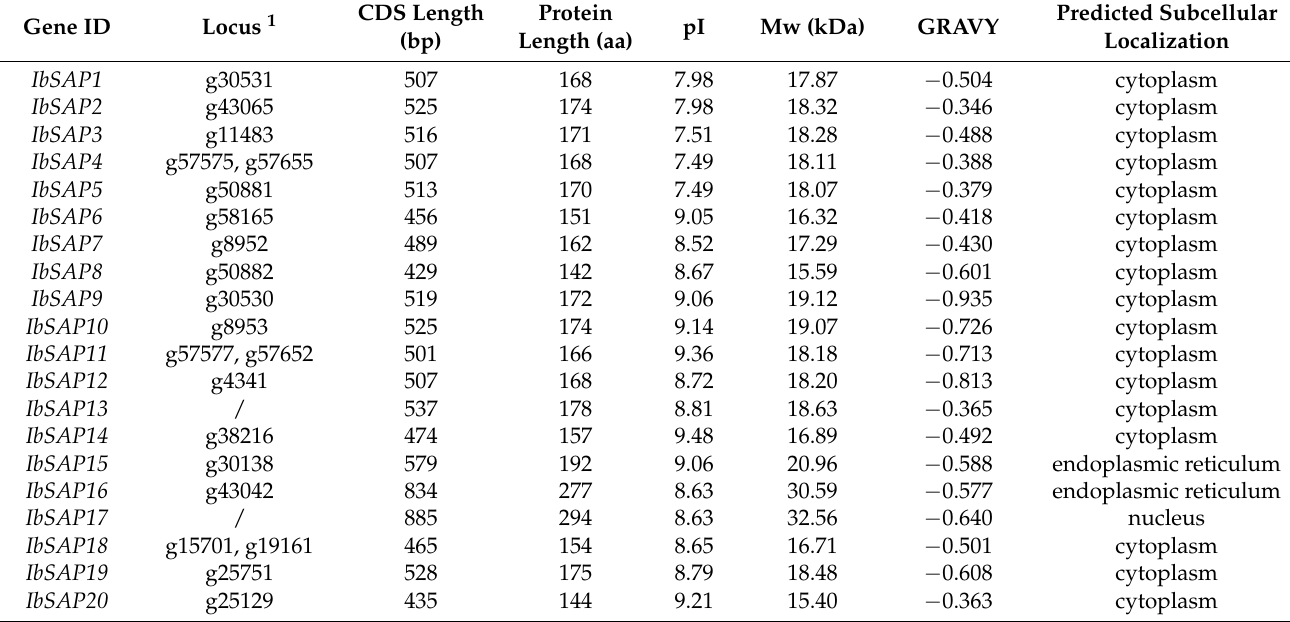
Table 1. A20/AN1 zinc finger domain containing proteins in